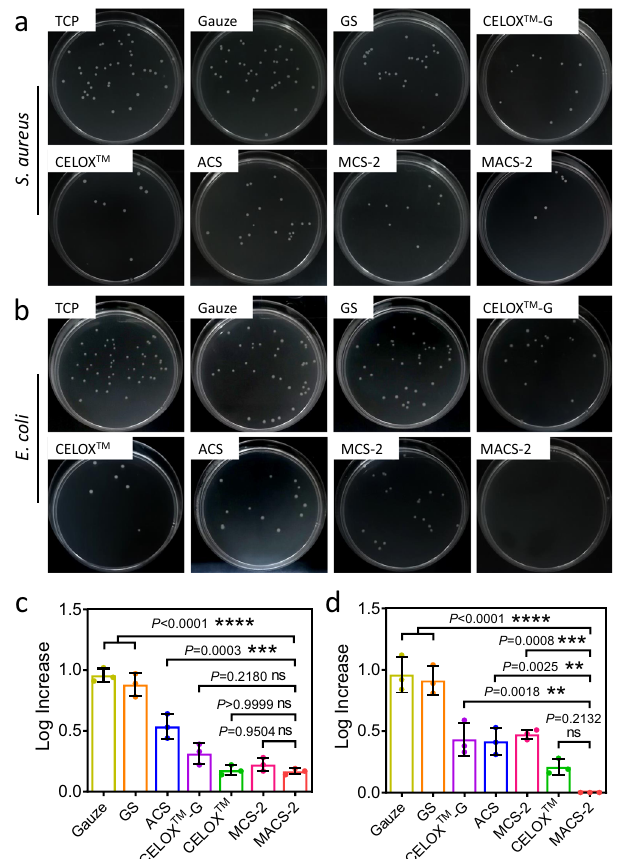
Fig. 8 In vitro anti-infective property of the MACS-2 and other hemostats. a , b Photographs of CFUs of S. aureus and E. coli grown on LB agar plates after contact with TCP, gauze, GS, CELOX TM -G, CELOX TM , ACS, MCS-2, and MACS-2, respectively. c , d Corresponding statistical results of the CFUs of S. aureus and E. coli . n = 3 independent samples. Data are expressed as mean ± SD. The signi fi cant difference was detected by one-way ANOVA with Tukey ’ s multiple comparisons test. The ‘ ns ’ indicated no signi fi cant difference, **P < 0.01, ***P < 0.001, ****P < 0.0001. S. aureus : staphylococcus aureus; E. coli : Escherichia